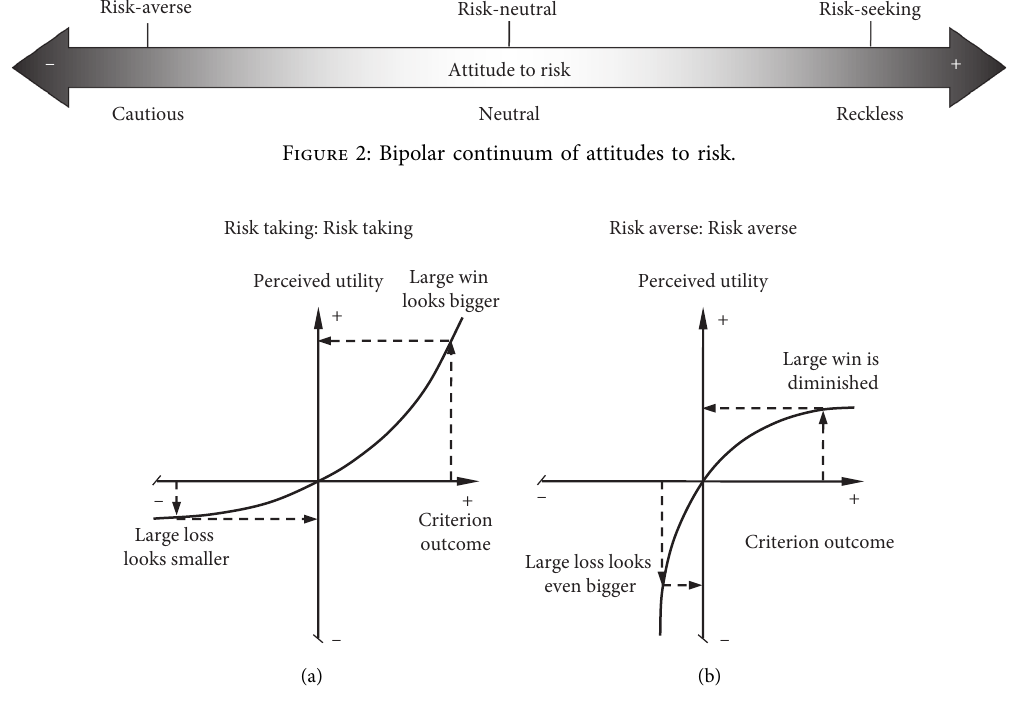
Figure 3: Gain and loss curve of different attitudes to risk. (a) Reckless. (b)